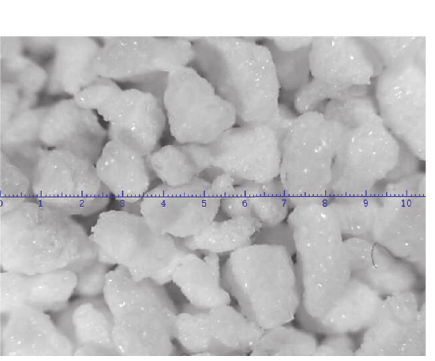
Figure 1: Glazed Hollow Bead dimension